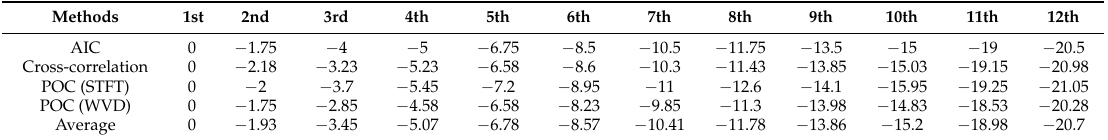
Table 4. The relative arrival times of the microseismic event using the four